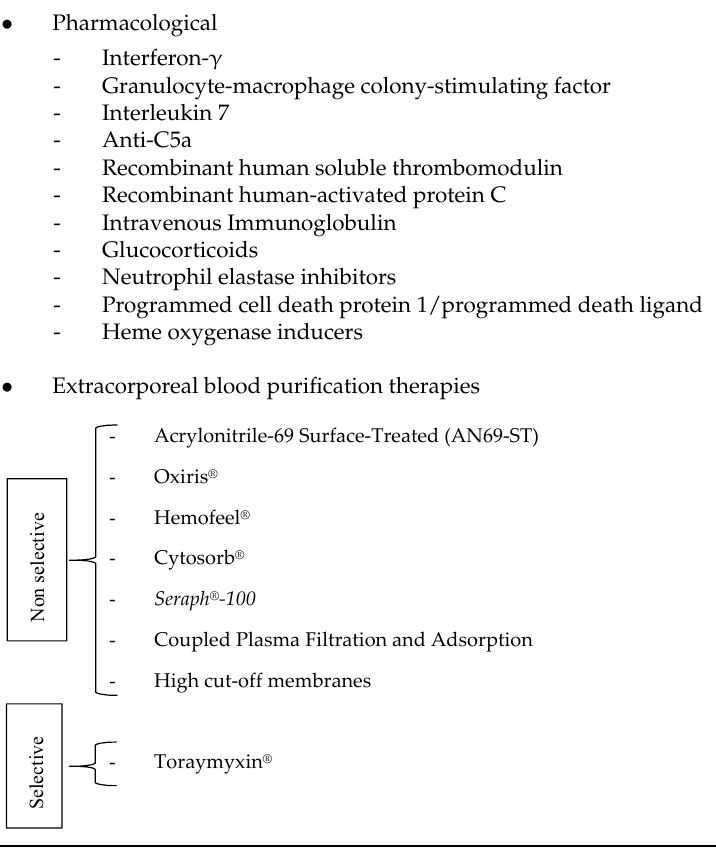
Table 2. Immune modulating strategies in critically ill septic patients. Immune Modulating Strategies in Sepsis